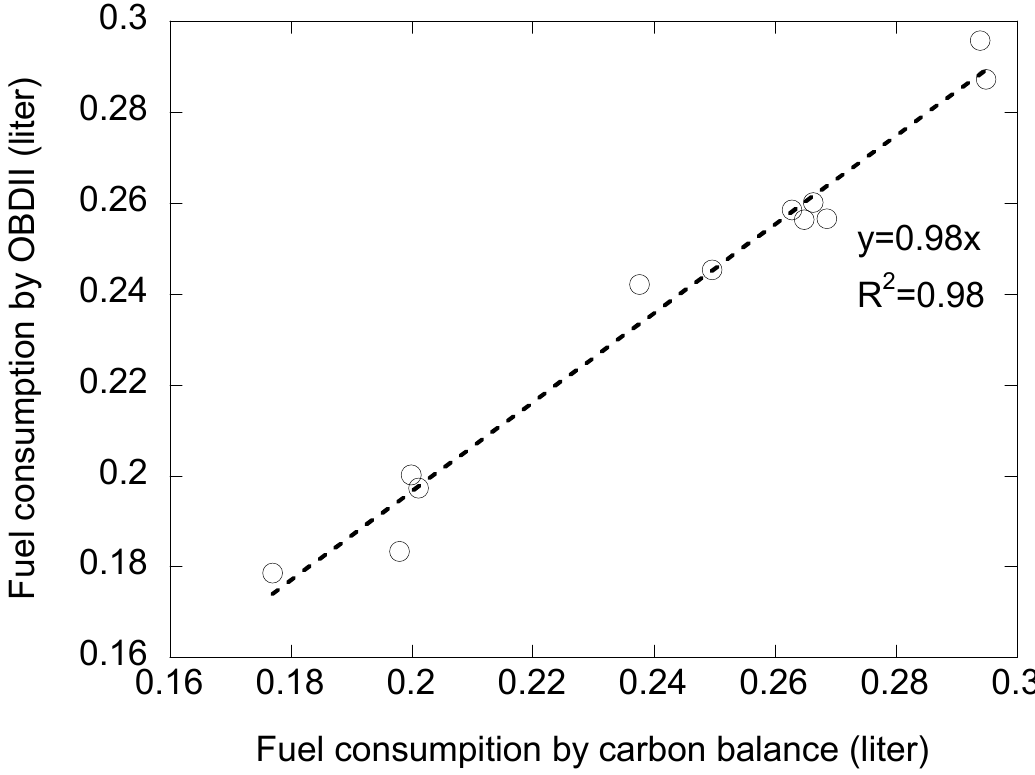
Figure 4. Comparison of fuel consumption between carbon balance and OBD-II methods over the SC03 cycle.